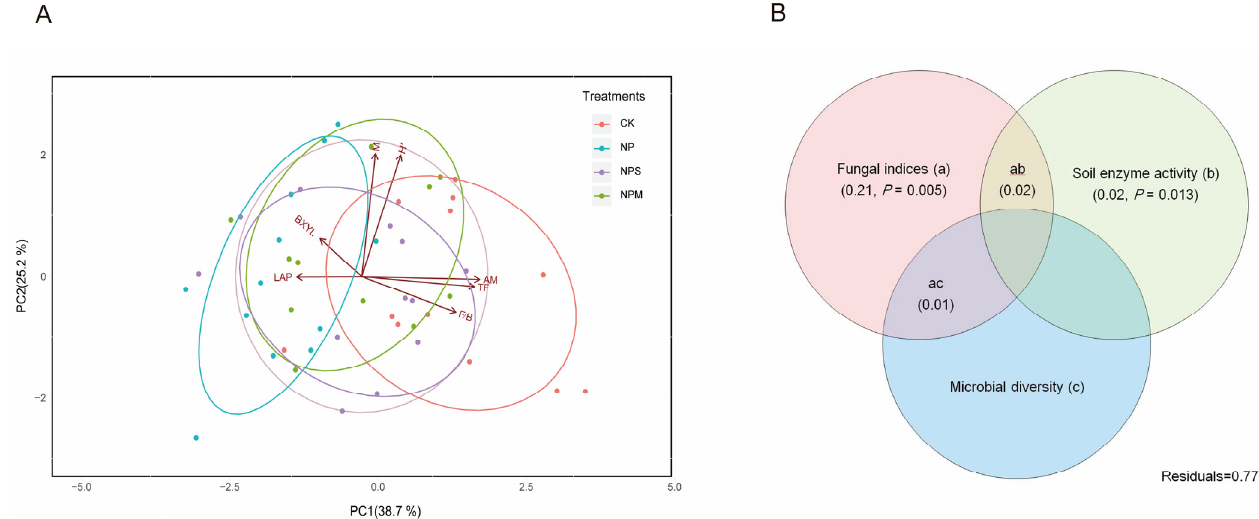
Figure 7. PCA analysis ( A ) of soil microbial properties and enzyme activity in macroaggregates (>0.25 mm) under 4 fertilization managements (CK, NP, NPS, and NPM). Variation-partitioning Venn diagram ( B ) of SOC accumulation variance partitioning among fungal indices (a), soil enzyme activity (b), and microbial diversity (c) predictor matrices in macroaggregates (>0.25 mm). Figure 7A, B were created using R version 3.2.2 (“R: A Language and Environment for Statistical Computing, R Core Team, R Foundation for Statistical Computing, Vienna, Austria (2016), https://www.R-project.org”, March 15, 2019). Fungal indices, soil enzyme activity, and microbial diversity contained three, two, and two factors, respectively.